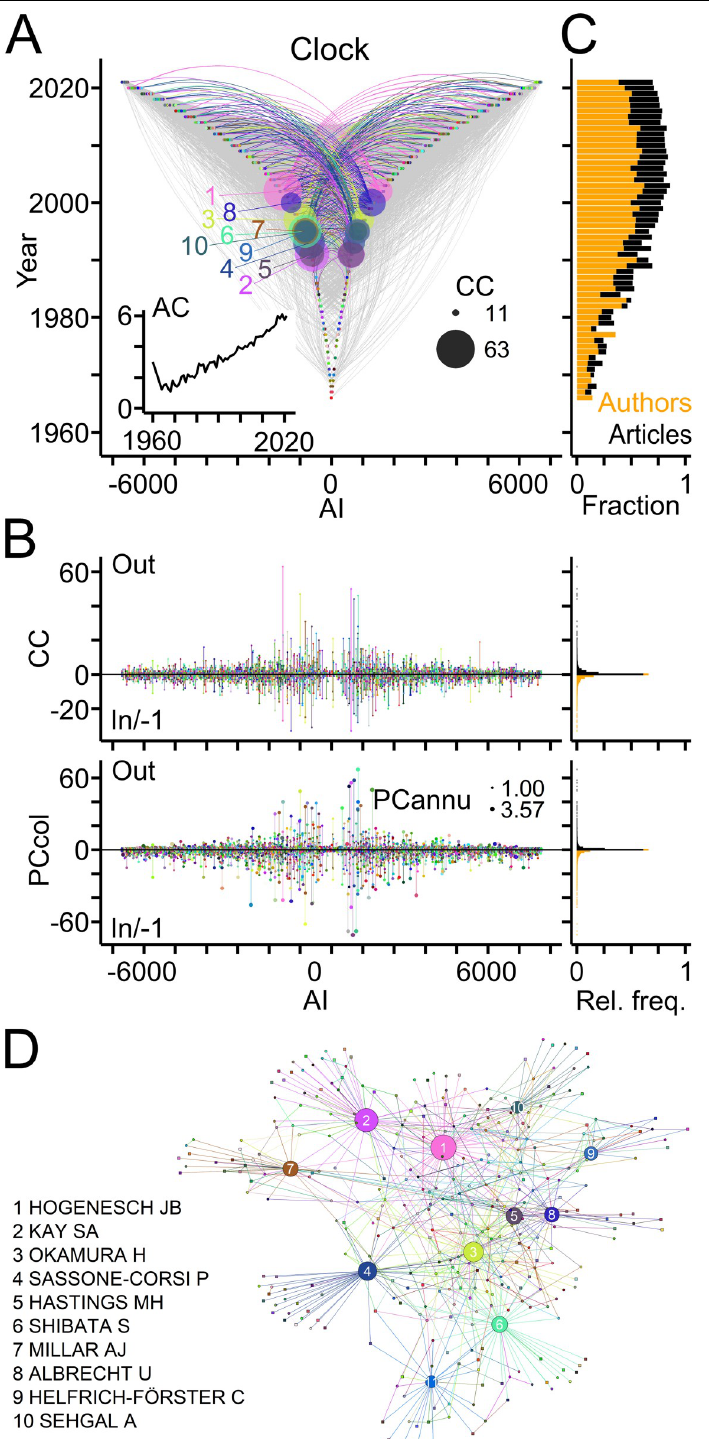
Fig 5. Collaborative connections in the Clock field. (A) TTG showing collaborations between last authors (out; negative AI) and co-authors (in; positive AI) derived from co-authorship on scientific articles. Connections of authors with ten highest connection count (CC) values (in+out) are shown in color. Circle areas indicate CCout and CCin values of these authors. Inset shows the mean author count (AC) per article published each year. (B) Left, counts of collaborators and of collaborative articles per author. Circle area indicates PCannu. Right, relative frequency distributions of parameters shown on the left. (C) Fractions of new collaborating authors (orange) and of collaborative publications (black) compared to total numbers per year. (D) Names of authors with top ten CC values and their networks. Circle area indicates CC values normalized to the maximum.